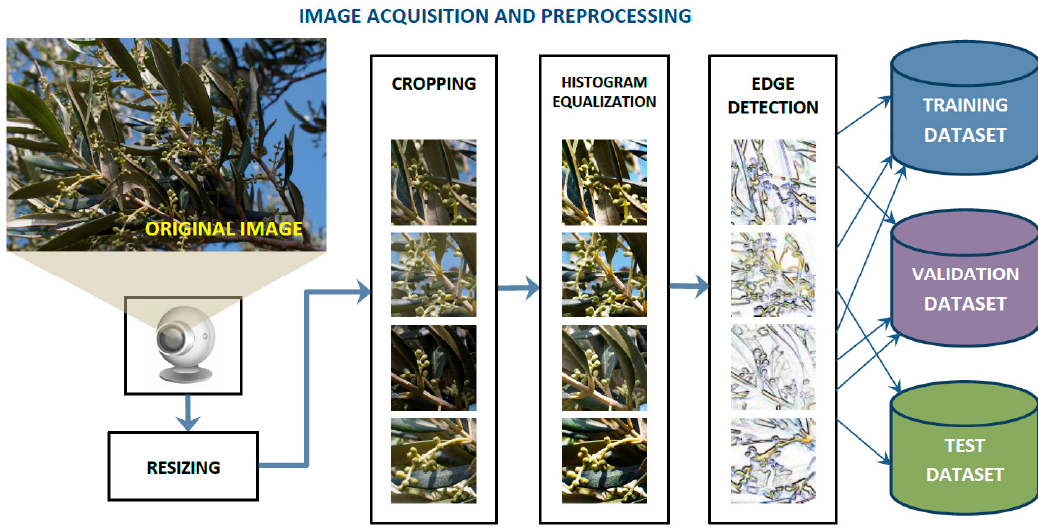
Figure 1. Flow diagram for image preprocessing.